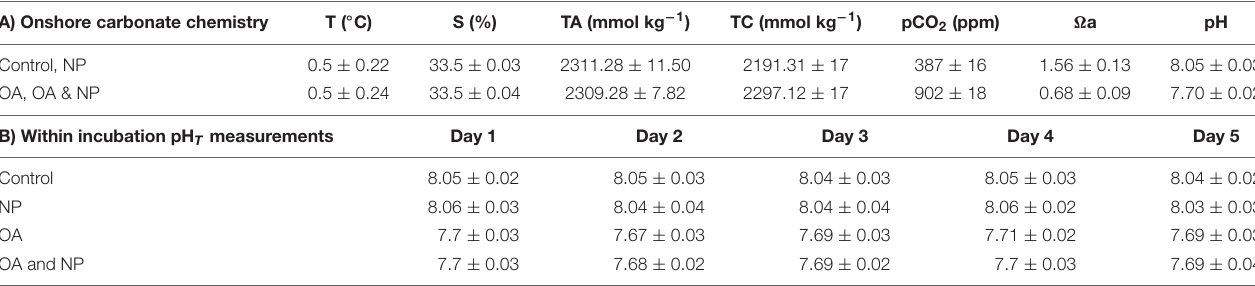
TABLE 1 | Mean ± SD of carbonate system parameters of SW cultures: water temperature (T, ◦ C), total alkalinity (TA, mmol kg − 1 ), total CO 2 (TC, mmol kg − 1 ), partial pressure of CO 2 (pCO 2 ppm), aragonite saturation state ( (cid:127) a), salinity (S, %), and pH T .